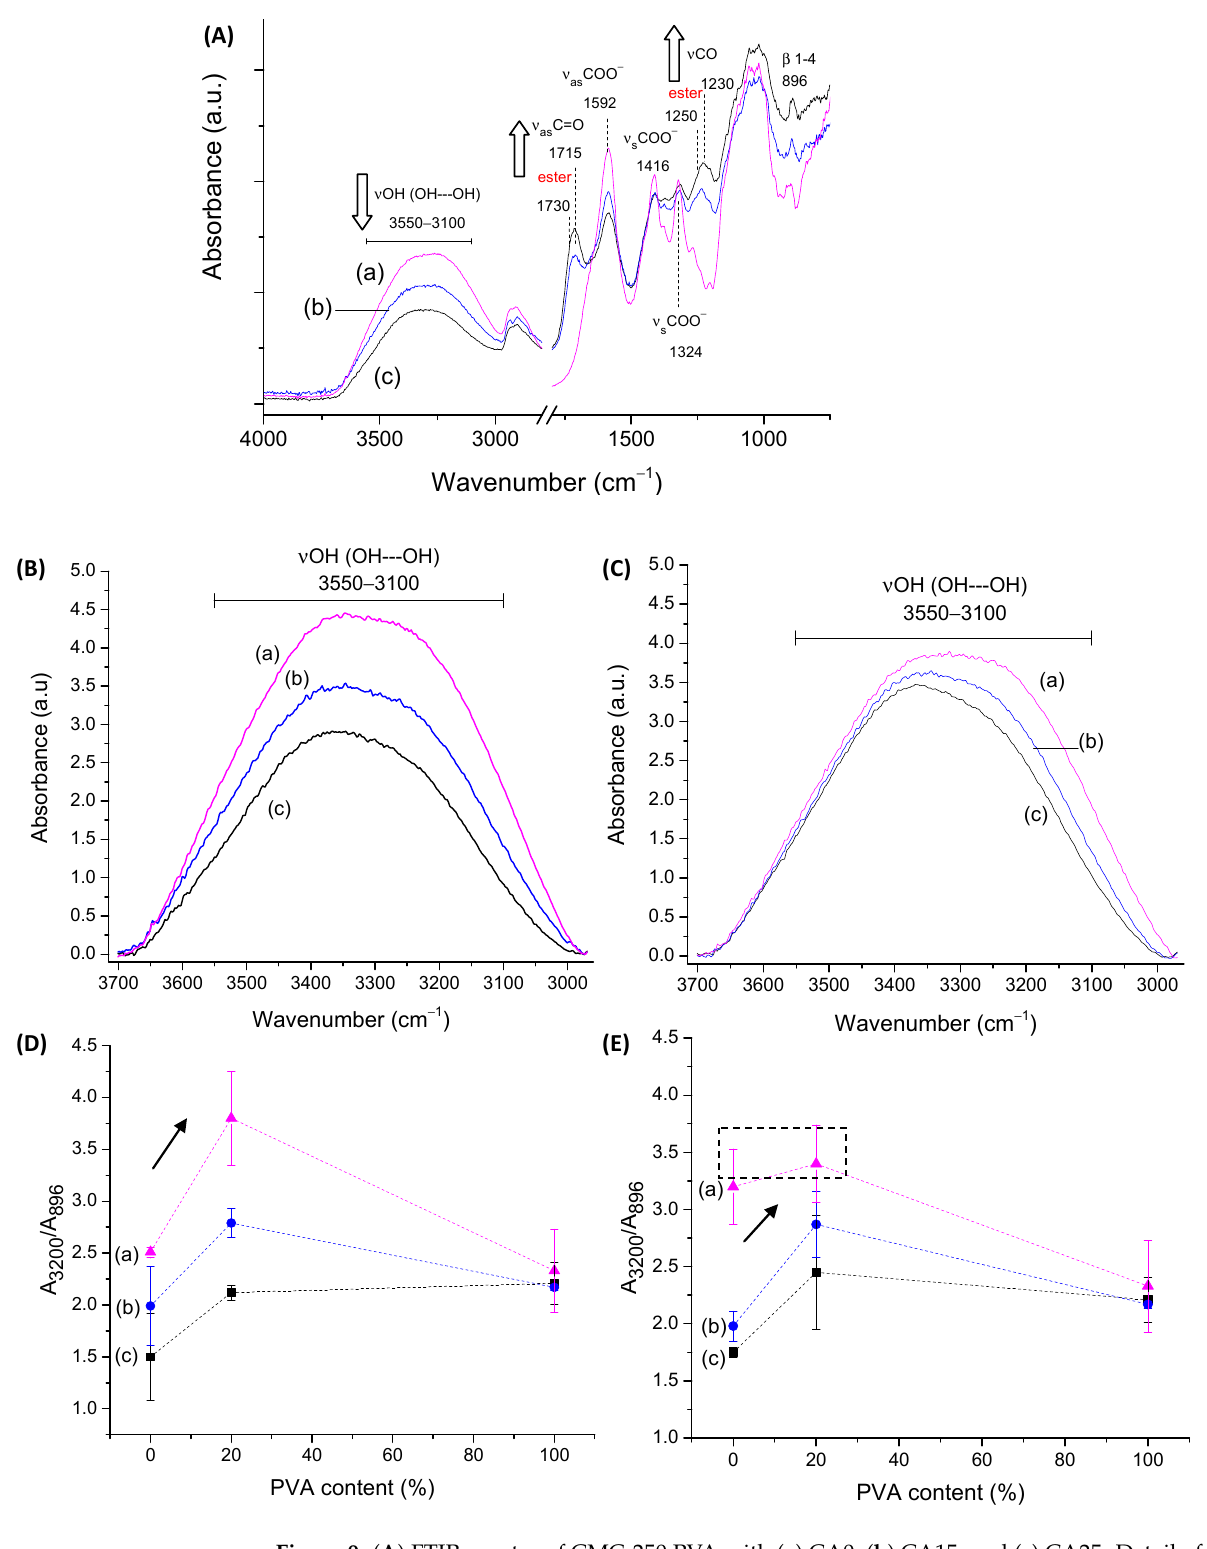
Figure 9. ( A ) FTIR spectra of CMC-250:PVA with ( a ) CA0, ( b ) CA15, and ( c ) CA25. Detail of FTIR spectra in the range of 3700–3000 cm − 1 for ( B ) CMC-250:PVA and ( C ) CMC-700:PVA (( a ) CA0, ( b ) CA15, and ( c ) CA25). Evolution of the ratio of bands A 3200 /A 896 as a function of PVA content for ( D ) CMC-250:PVA and ( E ) CMC-700:PVA (( a ) CA0, ( b ) CA15, and ( c ) CA25).